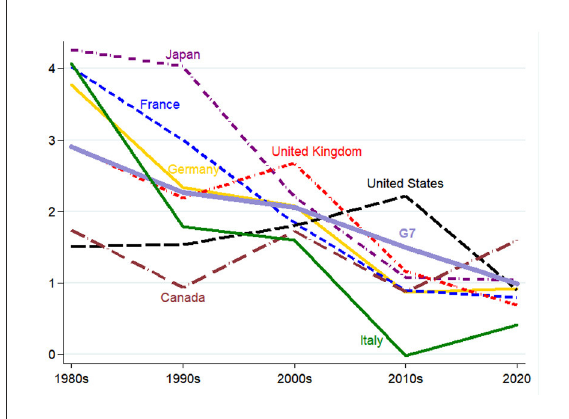
FIGURE3 Hourly labor productivity growth (in %, decade averages, 1980-2020, G7 countries). The chart depicts the average hourly labor productivity growth between 1980 and 2020 for G7 countries. Decade averages only available for 1980–1989; 1990–1999; 2000–2009; 2010–2019. Last observation is for 2020 and might be biased due to the effect of the COVID-19 pandemic on national statistics. Source: OECD, Statistics Portal, available at: https://stats.oecd.org/.